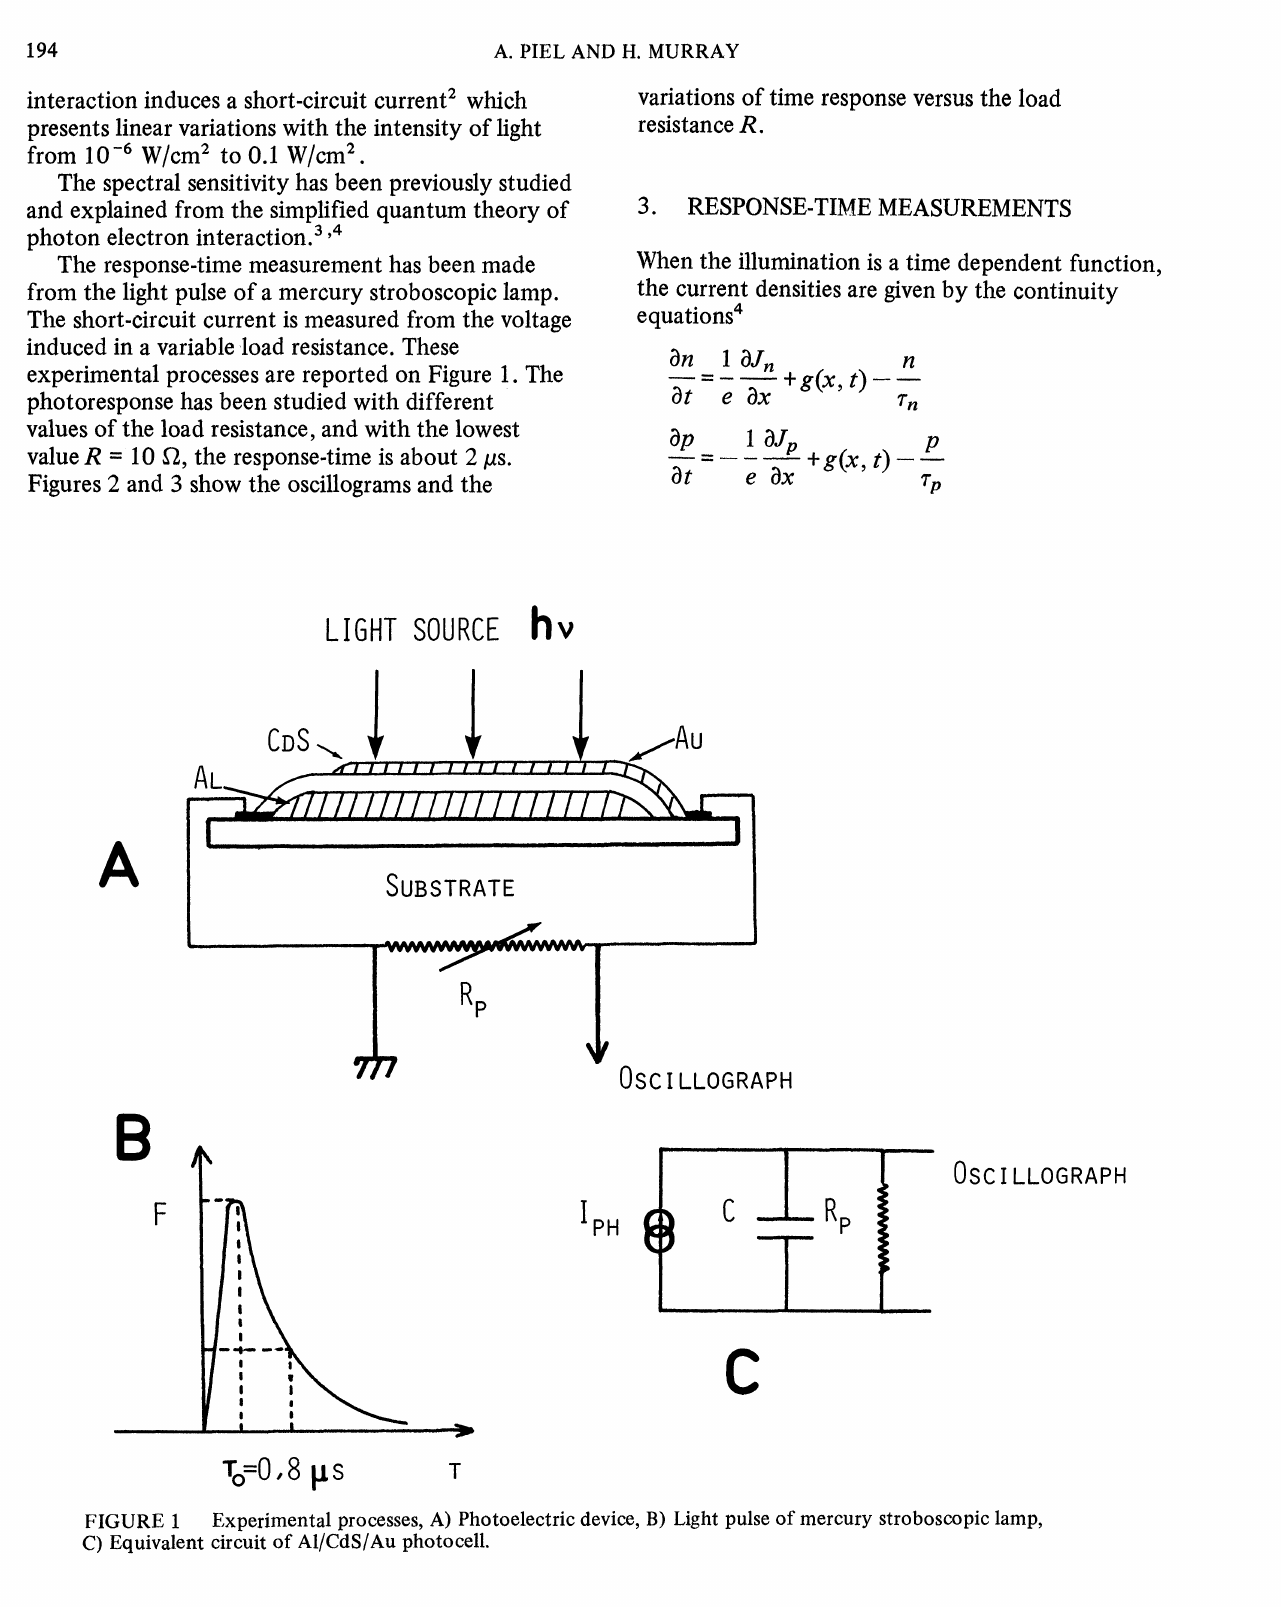
Experimental processes, A) Photoelectric device, B) Light pulse of mercury stroboscopic lamp, C) Equivalent circuit of A1/CdS/Au